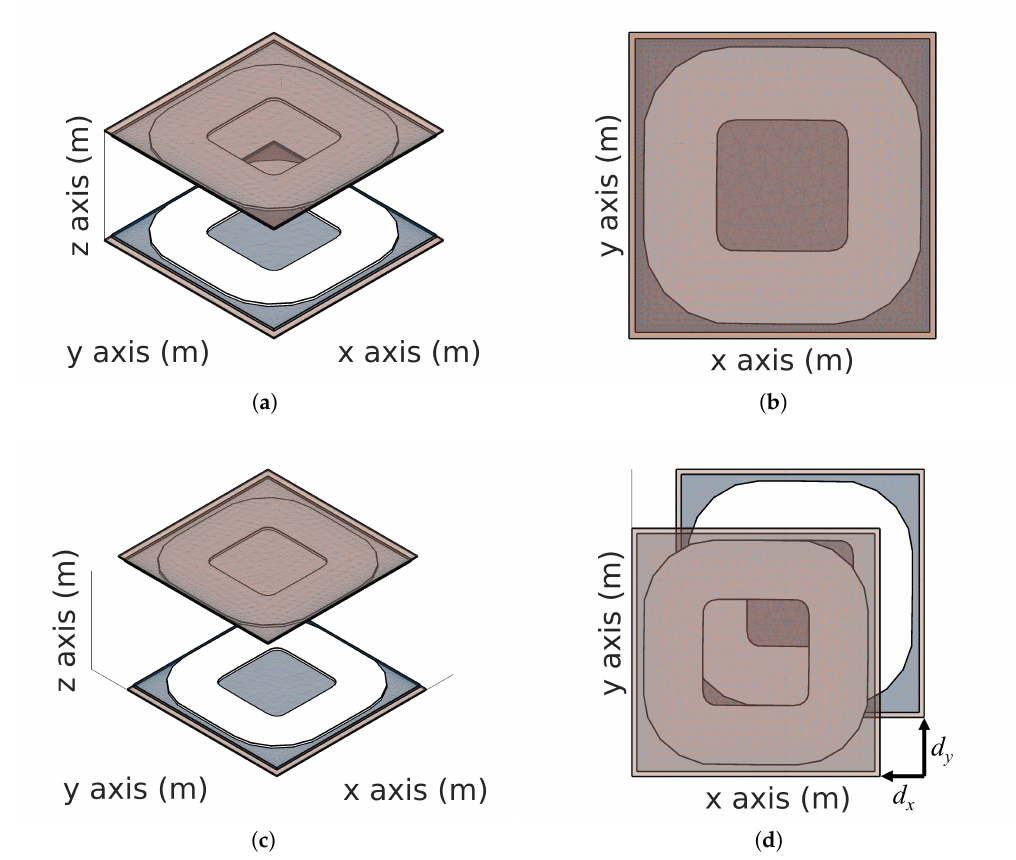
Figure 1. WPT2/Z3 system with perfect alignment ( a , b ) and maximum misalignment ( c , d